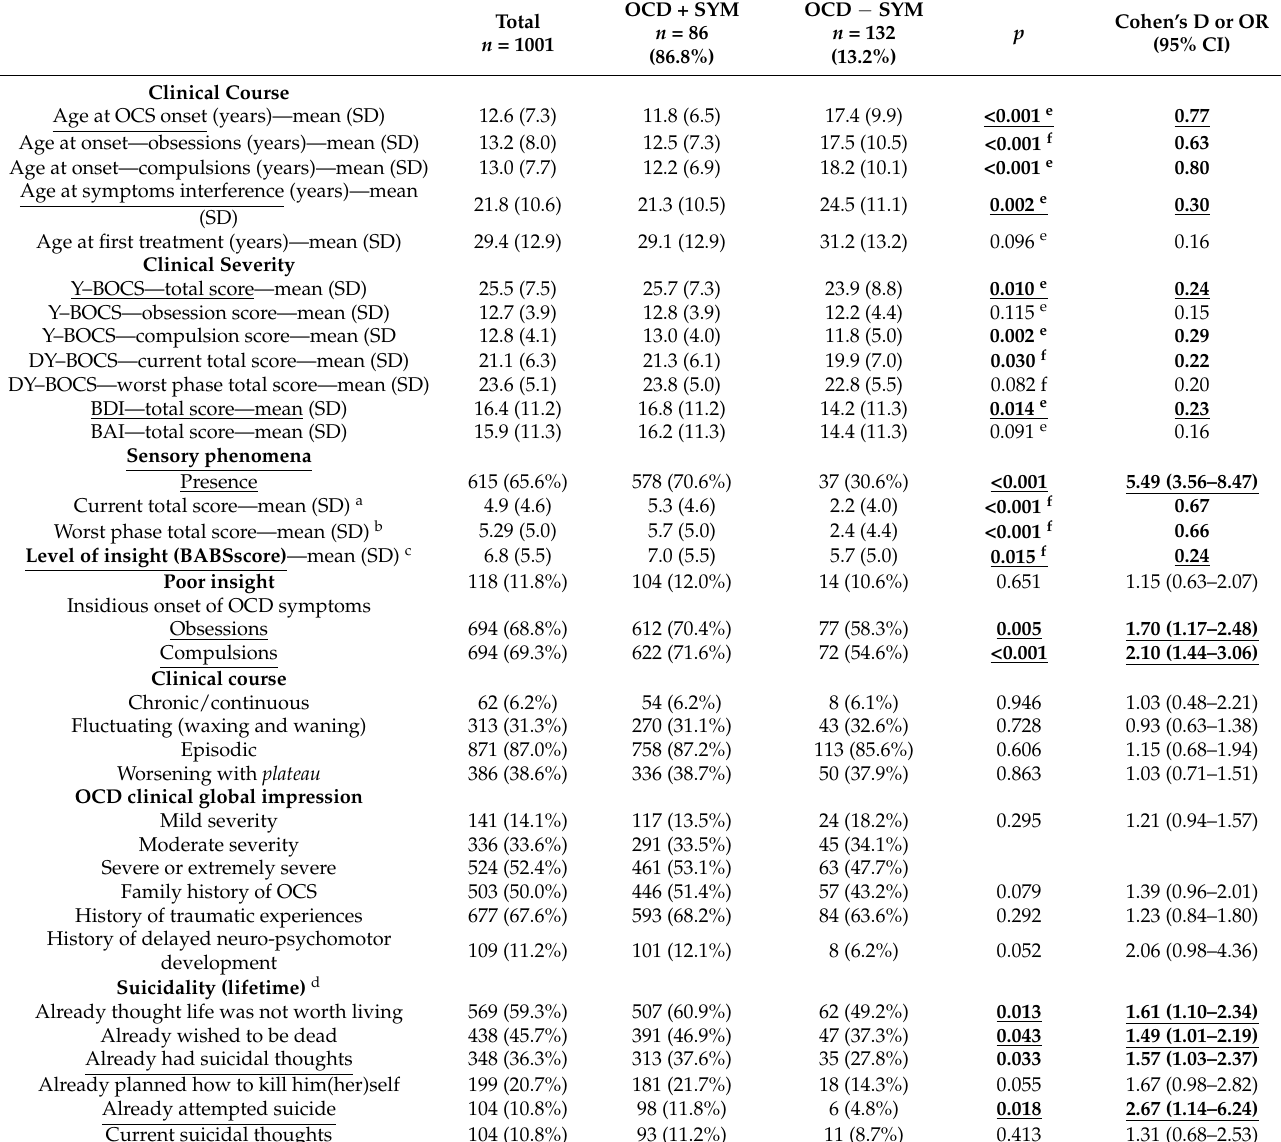
Table 2. Clinical characteristics of 1001 OCD patients with (OCD + SYM) and without (OCD − SYM) symptoms of the symmetry dimension.